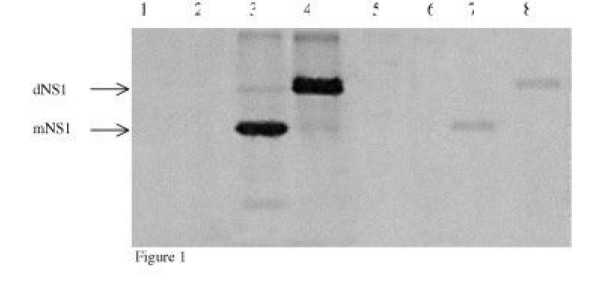
Study of mouse sera in RIPA with the TBE virus infected and radioactive labeled SPEV cell extracts. Lanes 1 and 2 – serum from intact mice; lanes 3 and 4 – mouse anti-NS1 sera [9]; lanes 5 and 6 – pooled sera of mice vaccinated with the vaccinia virus recombinant (W-NS1); lanes 7 and 8 – pooled sera from mice primed with W-NS1 after booster vaccination with pMV45. Odd lanes: samples were boiled before SDS electrophoresis to detect NS1-monomers; even lanes: samples were not boiled before electrophoresis to detect NS1-dimers. The position of monomers (mNS1) and dimers (dNS1) of the NS1 protein are marked with arrows.